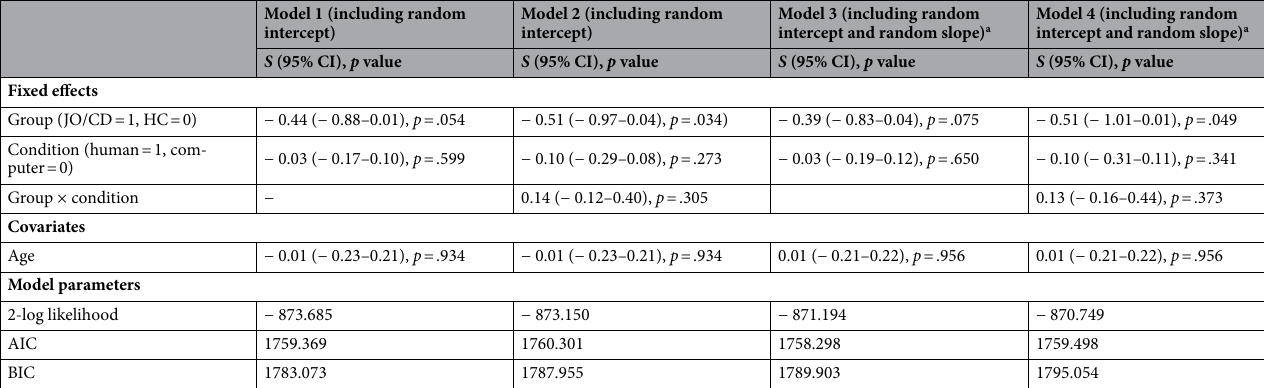
Table 2. Findings from mixed effect models with group and condition as fixed factors and subjects as random factors on investments. a Including random slope on condition (human = 1, computer = 0), JO/CD male juveniles who committed serious violent offenses and met criteria of conduct disorder, HC healthy controls, AIC akaike information criterion, BIC Bayesian information criterion, S standardized coefficient, CI confidence interval.